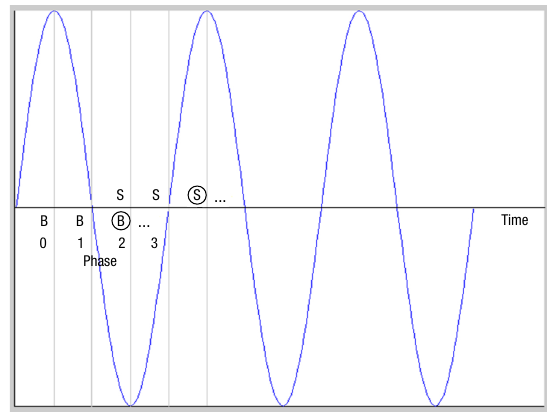
Fig. 2. Principle of phase angle searching, source: own